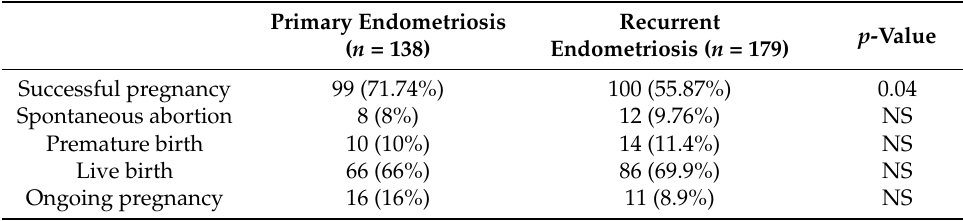
Table 6. Comparison of naturally conceived pregnancy outcomes between primary and recurrent endometriosis patients.